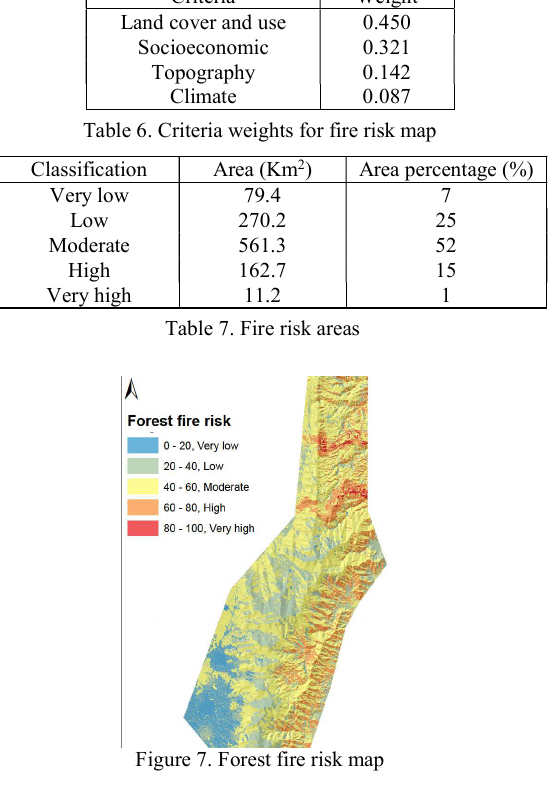
Figure 7. Forest fire risk map